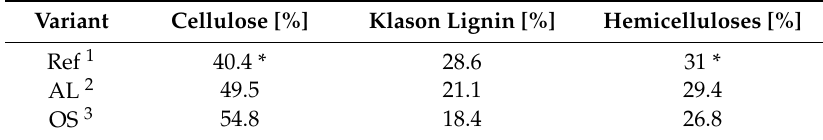
Table 2. Comparison of chemical composition of native and chemically treated spruce veneers.